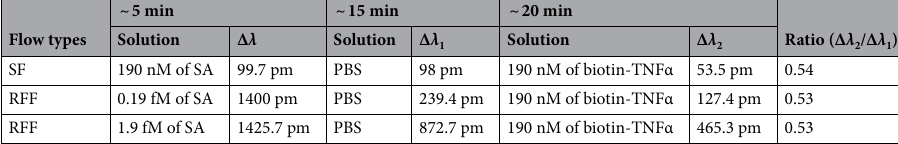
Table 1. Measured values of wavelength shifts by various combinations of Streptavidin solutions with flow methods in each testing procedure and calculated ratios by Δλ2/Δλ1 as described in Fig. 6b.